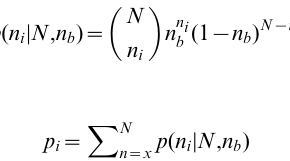
Table S1 Table with information about cancer types used in the analysis, non-neutral and hot-spot p values. The table giving details about all cancer types used in this analysis with the corresponding numbers of samples in them and the root cell type of each cancer. The table also has information about the non-neutral and hot-spot p-values obtained for all genomic bands in